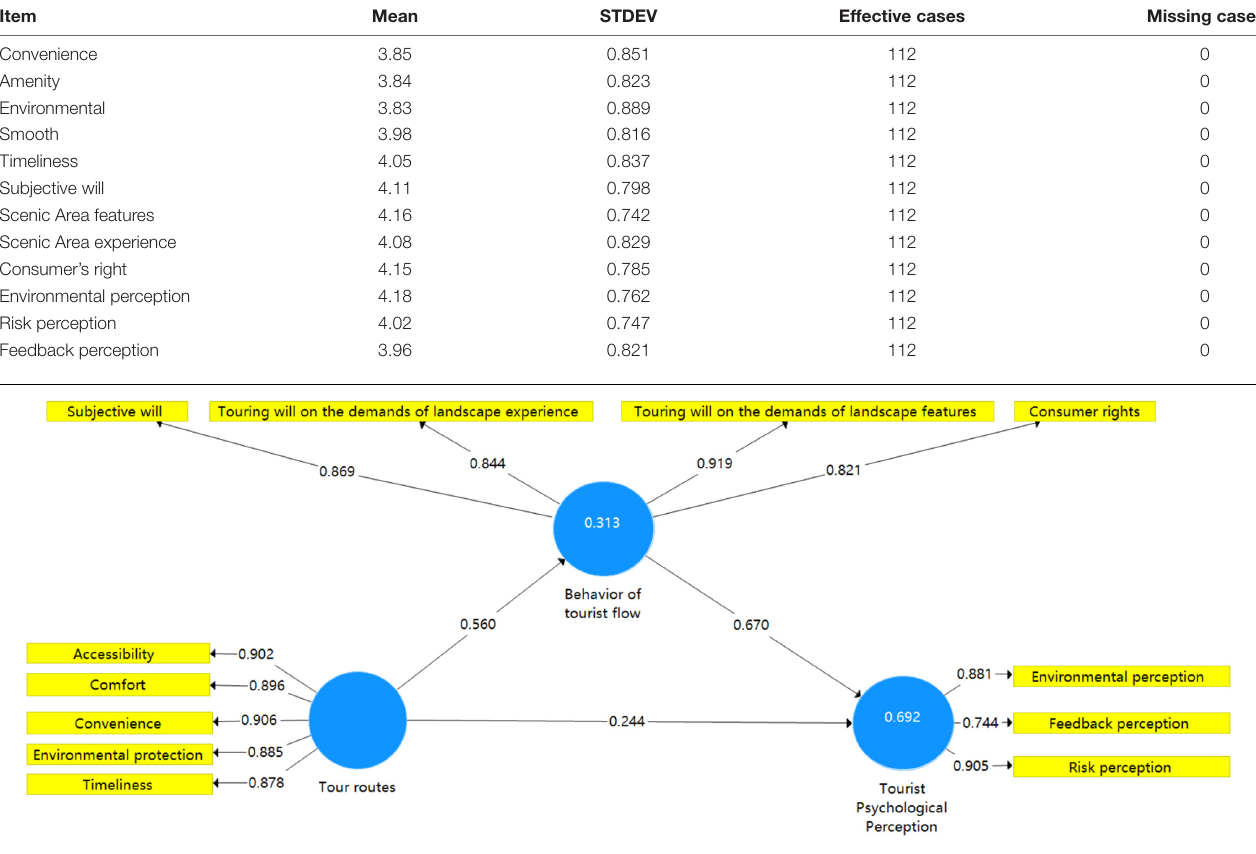
TABLE 3 | Descriptive statistics.